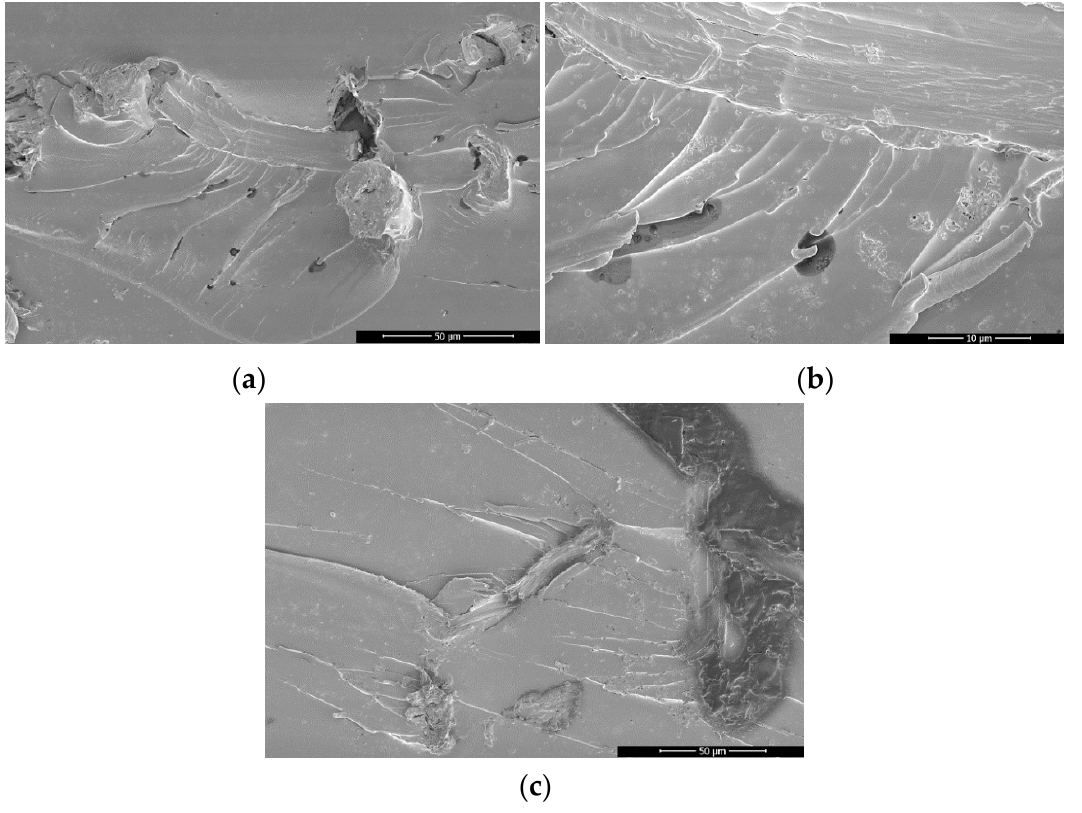
Figure 5. Micrographs of the composites epoxy/APTS functionalized hemp fibers: ( a, c ) 50 µm scale and its detail, ( b ) region at 10 µm.